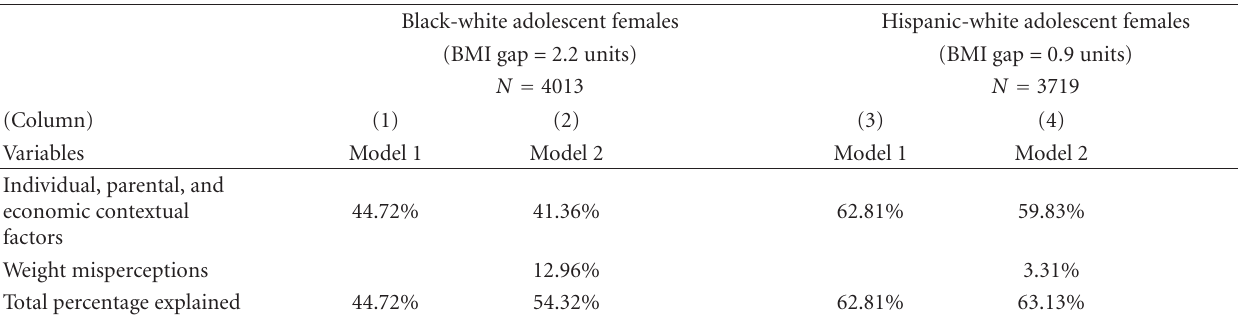
Table 3: Percentage contributions from decomposition model of racial and ethnic disparities in adolescent body mass